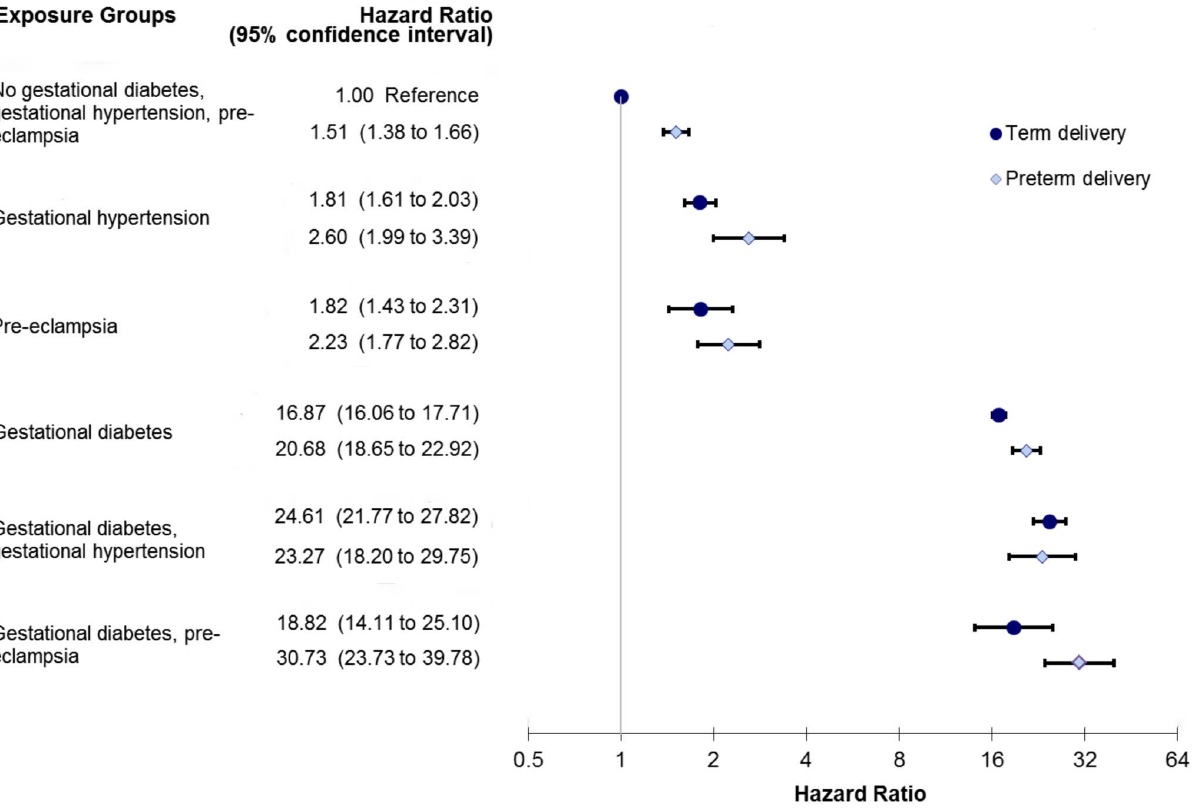
Figure 3. Sub-analysis modeling the relationship among preeclampsia, gestational hypertension, gestational diabetes, and preterm delivery in the development of diabetes. Model also adjusts for age, income quintile, prior hypertension, and co-morbidity using the Johns Hopkins collapsed ambulatory diagnostic group (CADG). The bands represent 95% confidence intervals. doi:10.1371/journal.pmed.1001425.g003 PLOS Medicine |